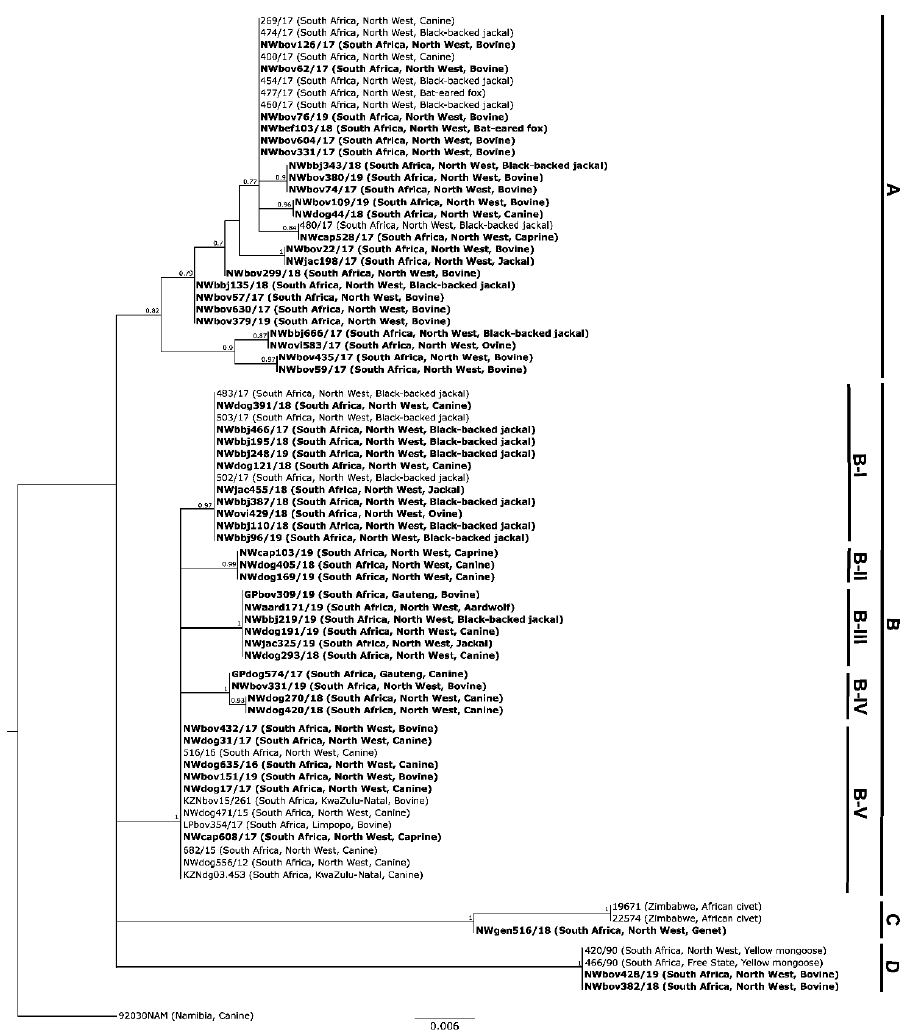
Figure 3. Maximum clade credibility phylogenetic tree for the cytoplasmic domain and G-L intergenic region sequences sourced from samples in South Africa and Zimbabwe (Table S1). The horizontal branch lengths are proportional to the homology between sequences within and between groups and all branches with a posterior probability of ≤0.75 were collapsed. A canine sequence from Namibia (92030NAM) was used to root the tree. The new sequences generated in this study are shown in bold (Table S1). All sequences in Clades A and B belong to the Africa 1-b lineage, while the sequences in Clades C and D belong to the Africa 3 lineage (Table S1).